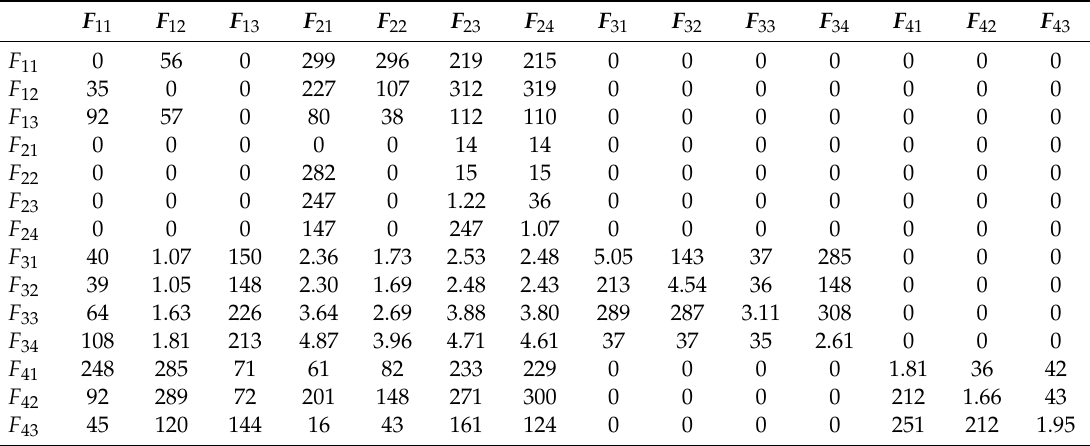
(cid:16) (cid:17) × 10 − 4 .